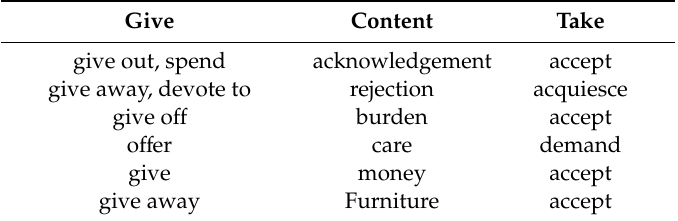
Table 1. Everyday language terms for interpersonal exchange processes that can be understood abstractly as directed relationships that constitute the desired (dynamic) equilibrium in the fundamental give–take dialectic of the social .